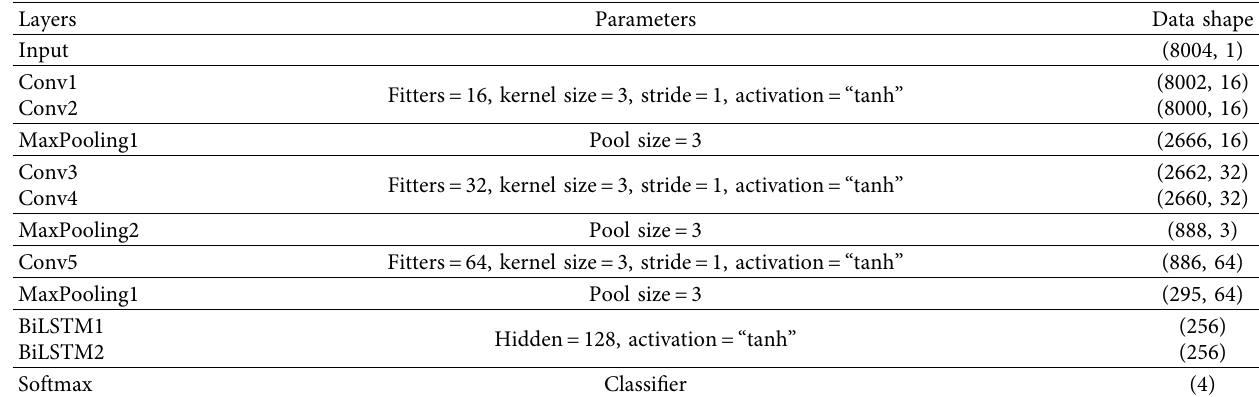
Figure 1: Te 1DCNNs-BiLSTM Table 2: Te structural parameters of the 1DCNN-BiLSTM network.